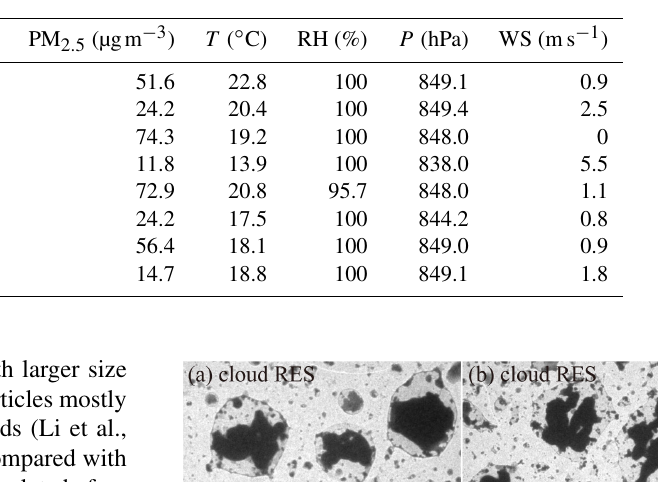
Table 1. Information on individual particle samples collected on Mt. Tai.